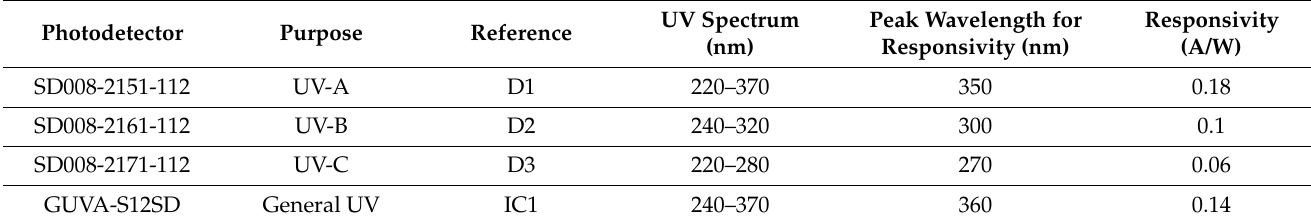
Table 1. Spectral parameters of the UV sensors.